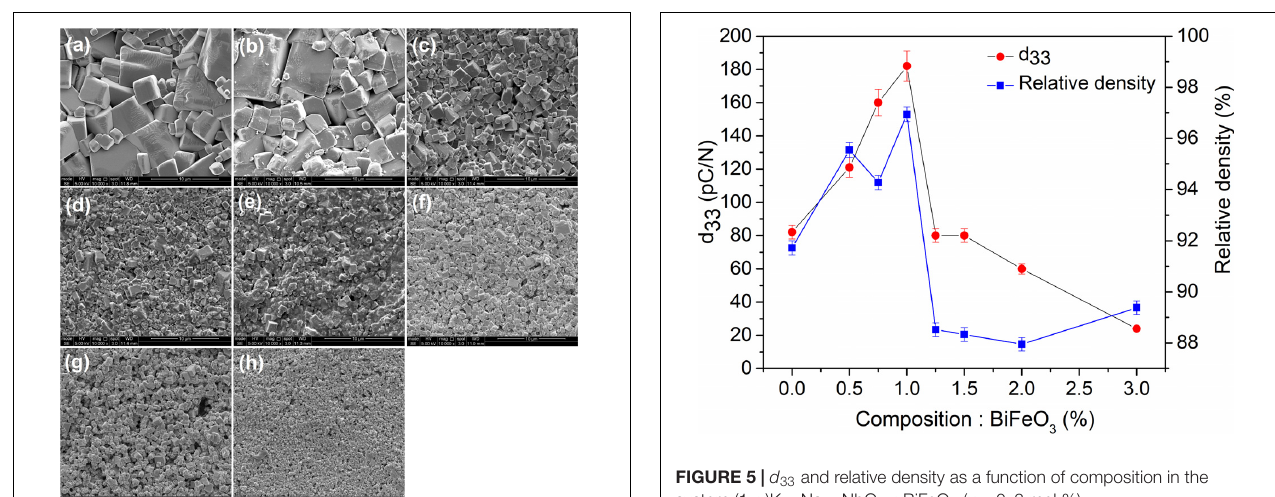
Frontiers in Materials |